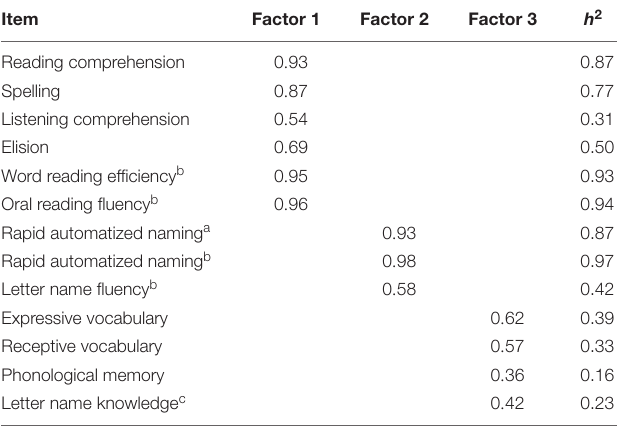
TABLE 4 | Factor loadings and communalities ( h 2 ) from the exploratory factor